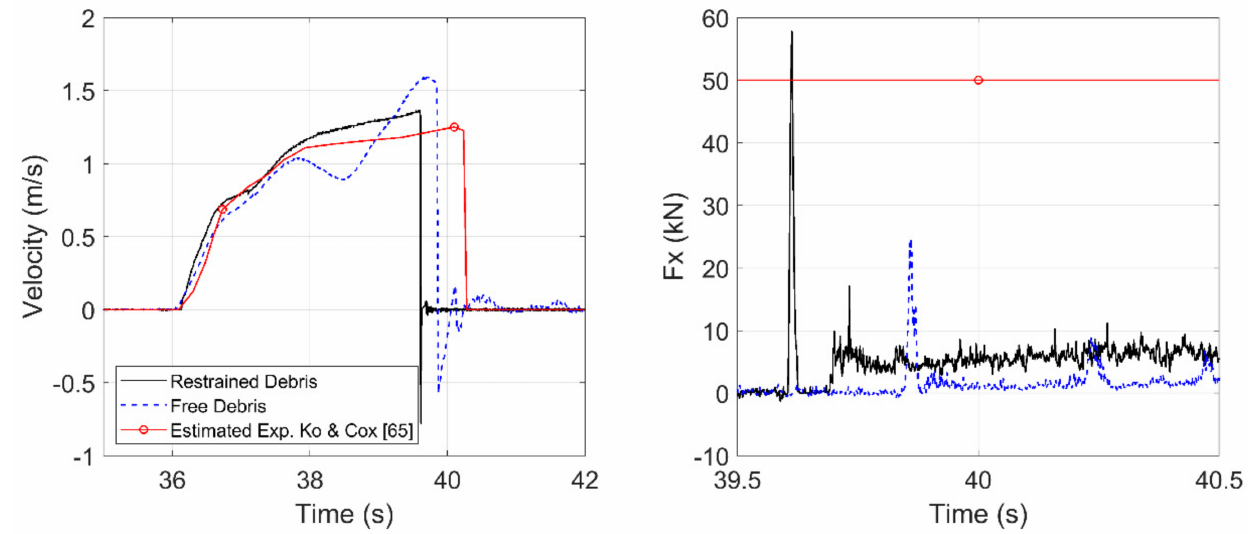
Figure 11. Debris velocity ( left ) and forces on the column ( right ). Experimental and numerical results (of restrained and free debris) for the hydrodynamic case h 1 = 2.496 m and T erf = 30